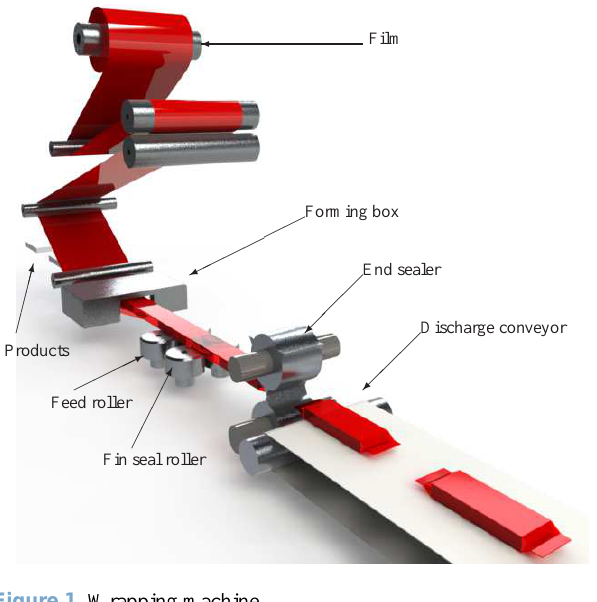
Figure 1. Wrapping machine.